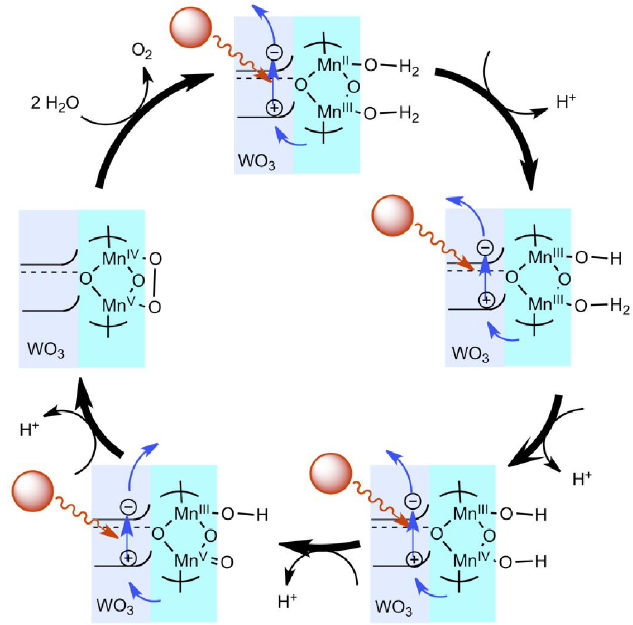
catalytic system in water Figure 5. Proposed mechanisms of Mn-terpy oligomer/WO 3 oxidation. Black arrows indicate the proton transfer reaction; blue arrows represent the O oxidation by receiving electron transfer steps. Mn-terpy oligomer oxidizes H 2 and undergoing a catalytic cycle, in which Mn photogenerated holes from WO 3 valance change is a proton-coupled electron transfer in a similar way to PS II oxygen-evolving